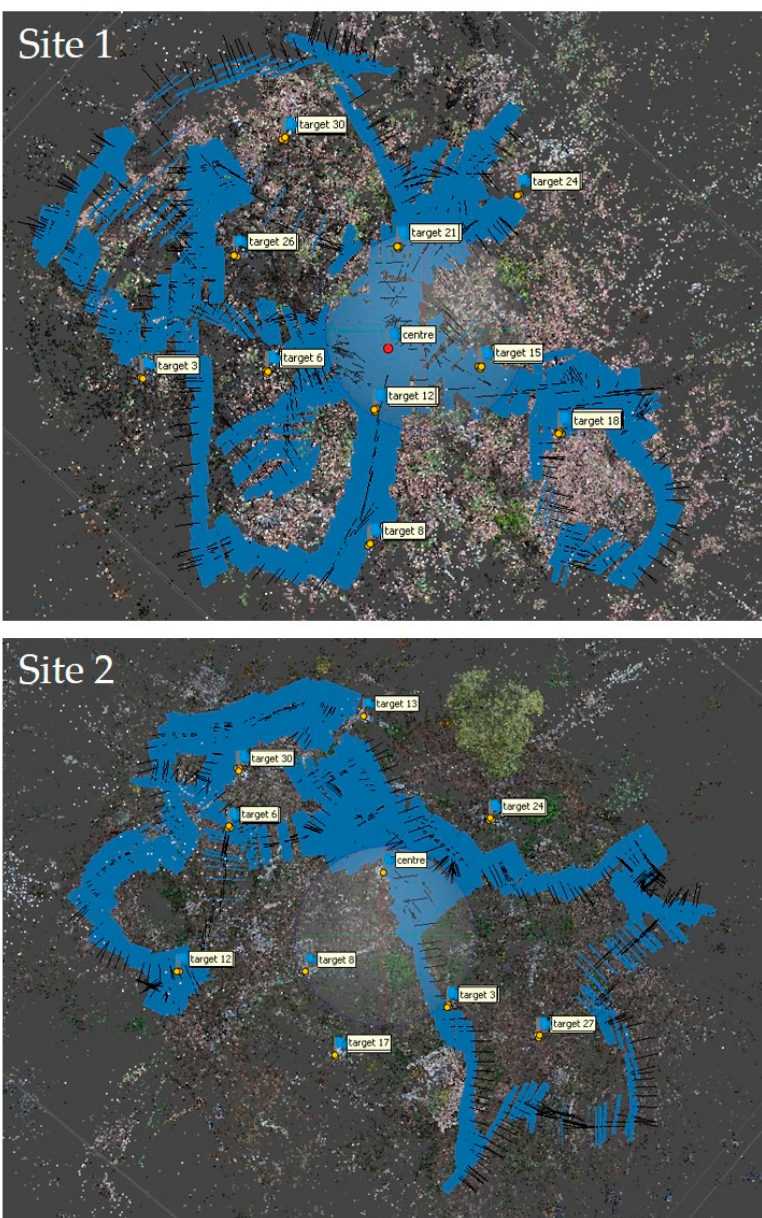
Figure A1. Above shows the locations of the 10 tetrahedron-shaped markers placed throughout each site as well as the locations of each image visualized in Agisoft Metashape. These coded targets were placed to assist the image alignment process by providing “true” matches to the solver.